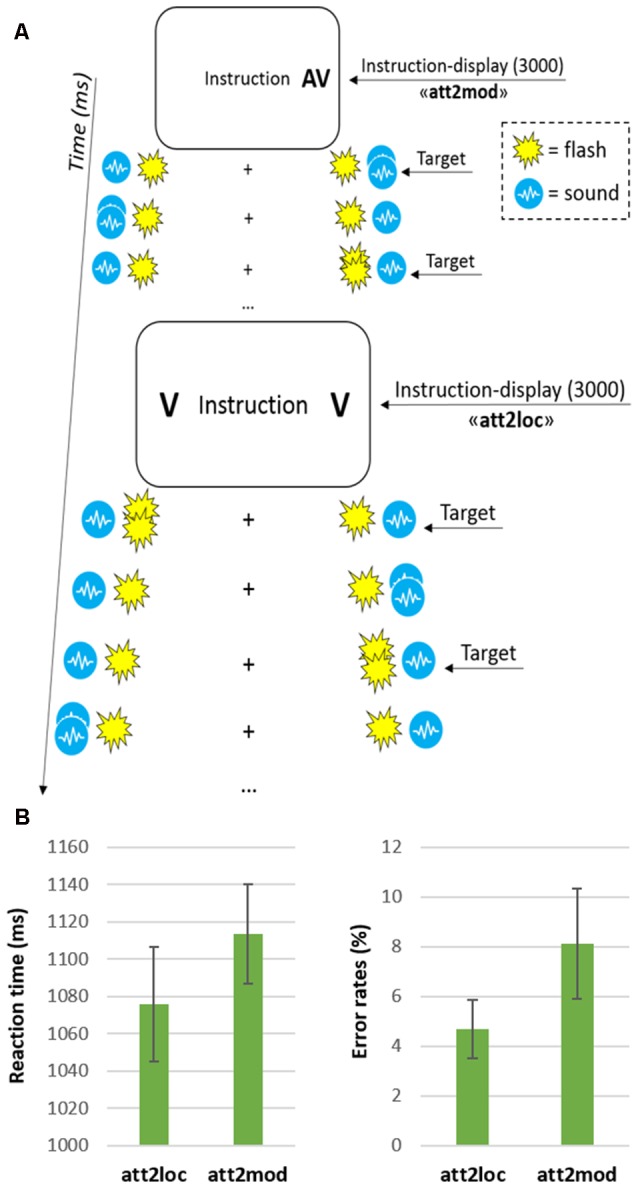
(A) Schematic diagram showing from top to bottom an example of a few trials in the “attending two modalities” (att2mod) and “attending two locations” (att2loc) conditions. Each block consisted of 10 trials and began with an instruction display signaling the current task. On each trial, the stimulation was always bilateral with two independent audiovisual streams on each side. Depending on the current condition, participants monitored one or two of the four sensory streams in one or two hemifields, responding to double pulses (i.e., the targets) in the relevant stream/streams while ignoring all other stimuli; (B) Reaction times (left graph) and error rates (right graph) for the two main conditions (att2loc and att2mod). The error bars represent the standard error of the means.